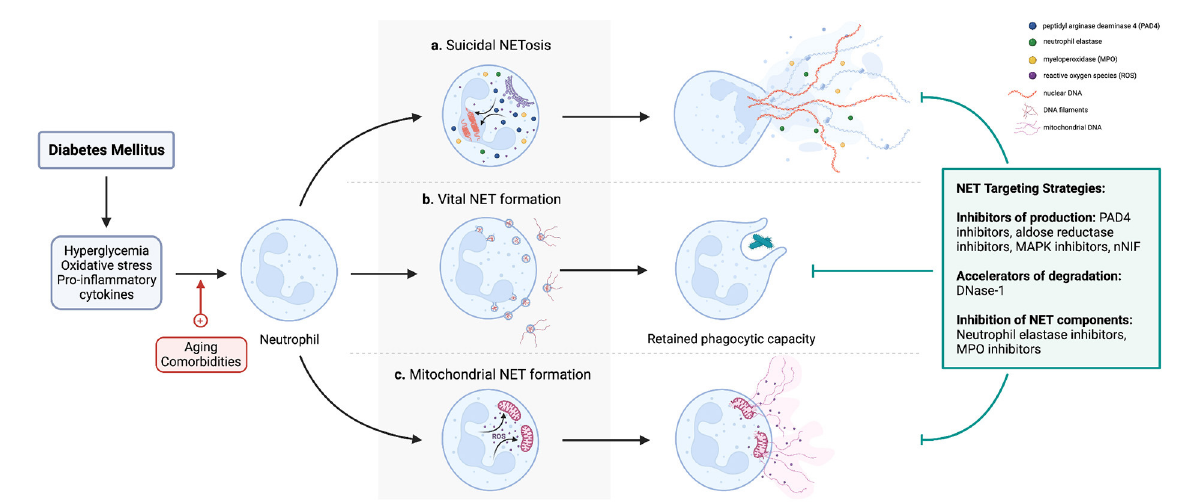
FIGURE1 A diagrammatic representation of the different pathways of NETosis and NET production. Importantly, whereas (a) NETosis entails release of NETs with concomitant neutrophil apoptosis, neutrophils retain viability and effector functions after (b) vital and (c) mitochondrial NET production. In the context of diabetes, hyperglycemia activates NADPH oxidase, and oxidative stress and elevated pro-inflammatory cytokines consequent to a chronic sterile inflammatory state induce NETosis and NET production. However, if and how age and co-existing cormorbidities such as obesity contribute to these pathways are unclear. Since numerous studies have implicated NETs in the pathogenesis of diabetic complications, strategies to mitigate the effects of NETs include preventing their production (e.g., PAD4 inhibitor, NE inhibitors), accelerating their degradation (DNAse-1), or inhibiting NET components to ameliorate their respective pathologic effects (NE inhibitors, other protease inhibitors e.g., MMP-9). However, it should be noted that no drug currently targeting NETs is approved for prevention or treatment of diabetic